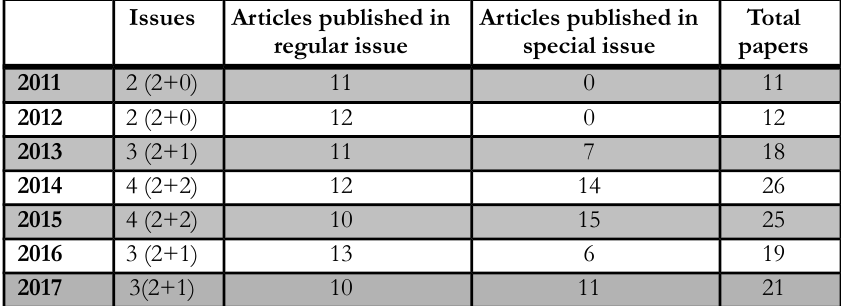
Table 2. Articles published evolution from 2010 to 2017